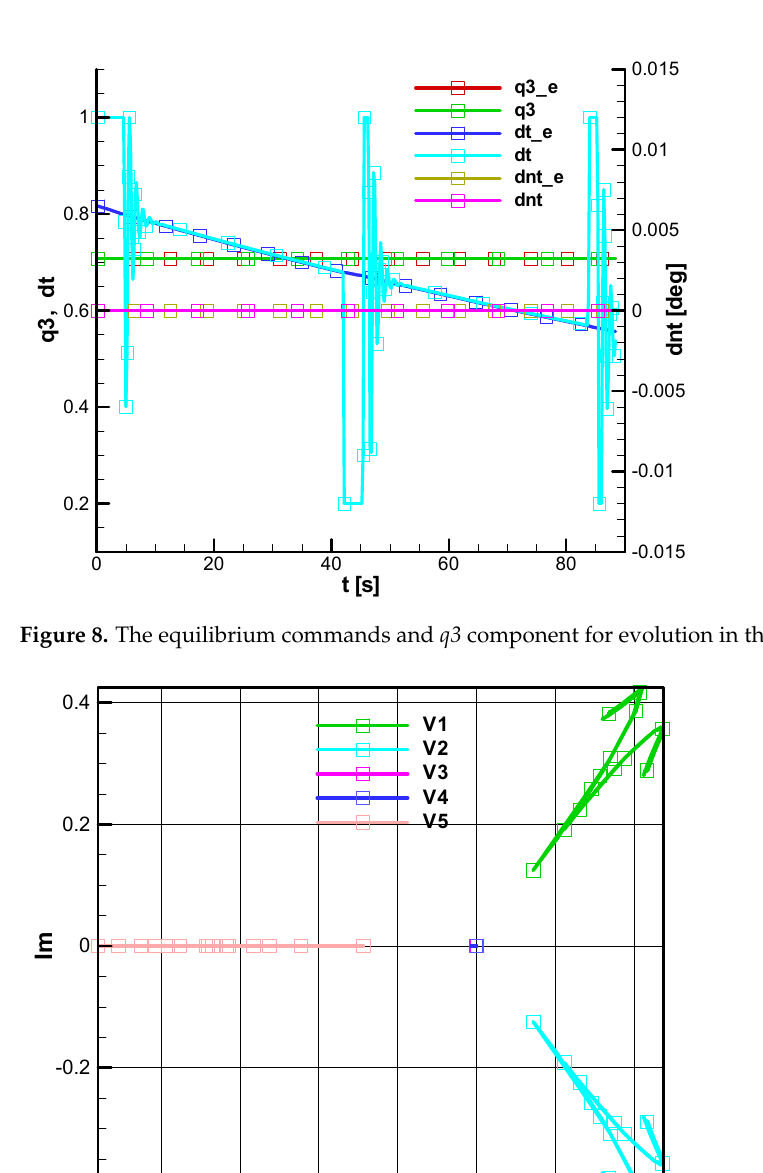
Figure 7. Vertical ascending—descending trajectory.